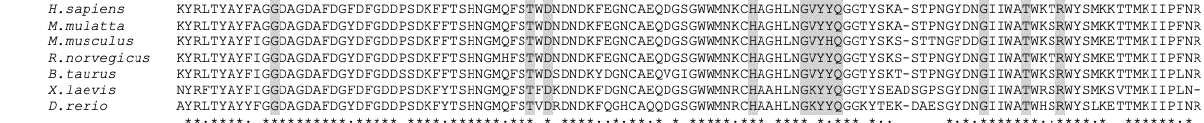
Figure 2. Localization and conservation of HHHS -causing mutations in the fibrinogen γ nodule. ( a ) The localization of all the mutations responsible for the HHHS phenotype, described in the literature, are indicated as grey spheres (in case of missense mutations), and orange spheres (in case of deletion). Mutations are numbered on the mature protein. The fibrinogen chains (A α , B β , γ ) are represented in yellow, cyan, and green, respectively. The model was obtained using the pdb structure 3GHG, and the UCSF Chimera package. ( b ) Multiple alignments of the fibrinogen γ chain terminal regions of different species. Sequences were retrieved from NCBI, and aligned using clustalW. The last line of the alignment shows in a schematic way the conservation among species. The * symbol indicates a conserved residue, the : symbol indicates conservation between groups of strongly similar properties, the . symbol indicates conservation between groups of weakly similar properties, the space indicates lack of conservation. Amino acids shaded in grey corresponds to those involved in HHHS mutations.